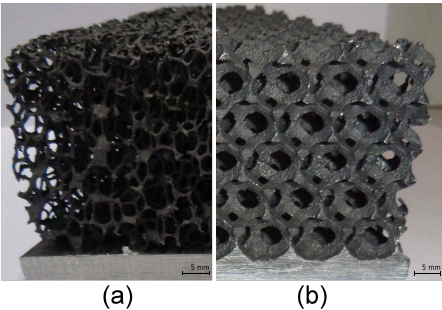
Figure 2. An example of a metal foam produced by ( a ) investment casting of a polymer foam precursor and ( b ) leachable bed